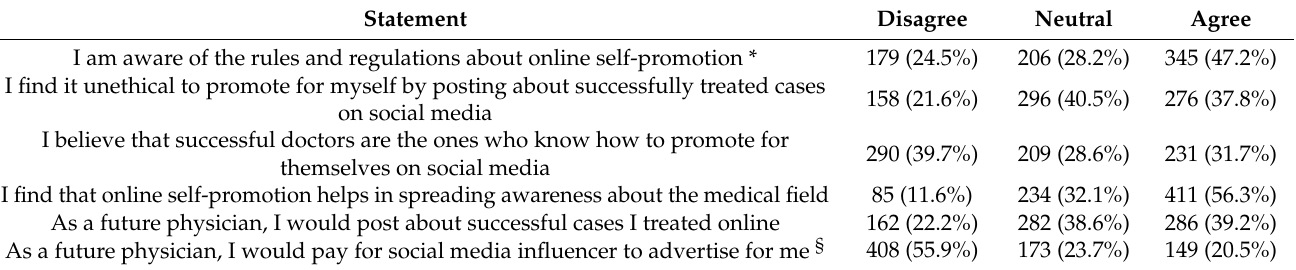
Table 4. Medical students’ view on physicians’ online self-promotion activities (n =